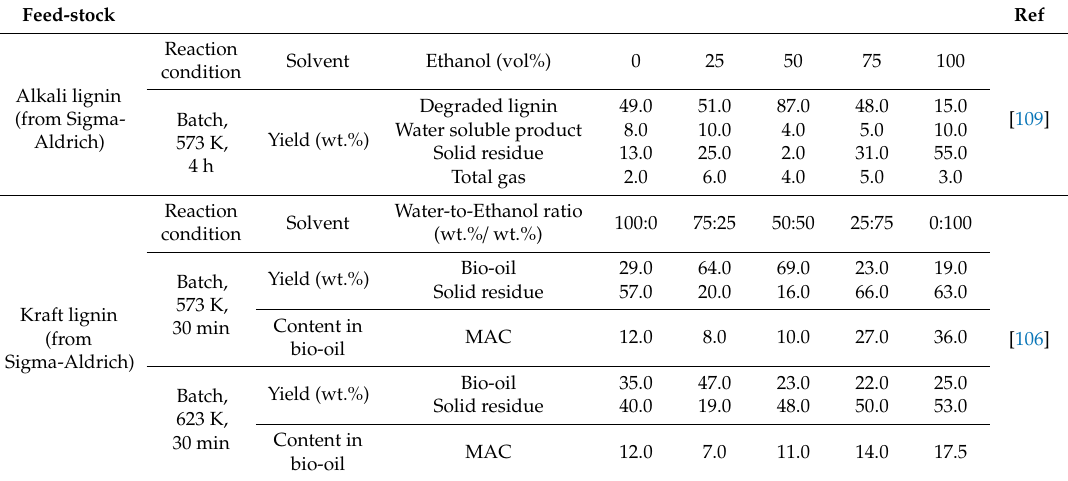
Table 9. Summary of HTL experiments with ethanol as